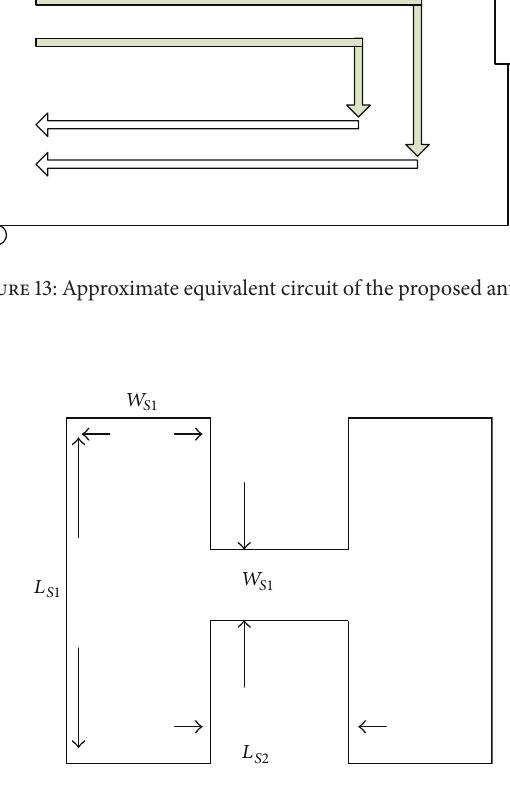
Figure 14: geometry and parameters of the H-shaped